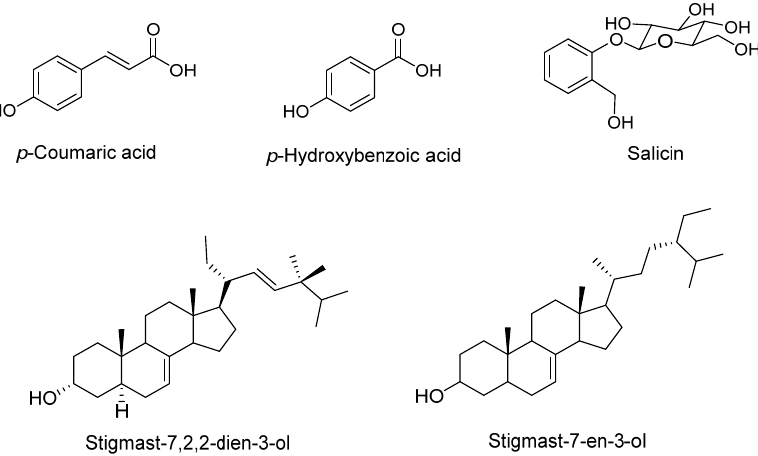
Figure 2. Main molecules identified in the aqueous extract of the fruit of C. ficifolia.